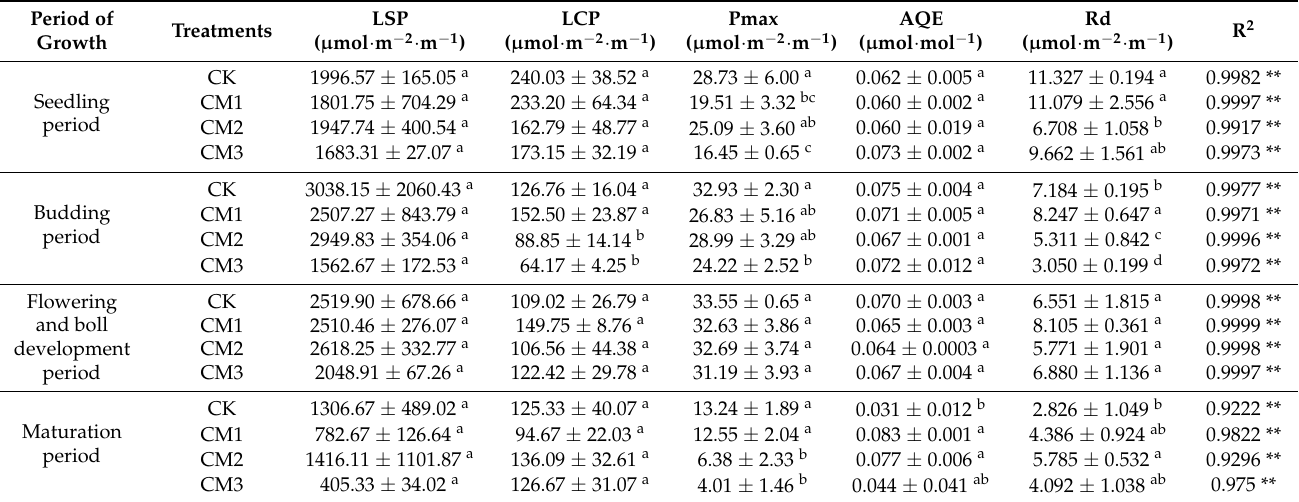
Table 1. Cotton light-response characteristic parameters at different growth